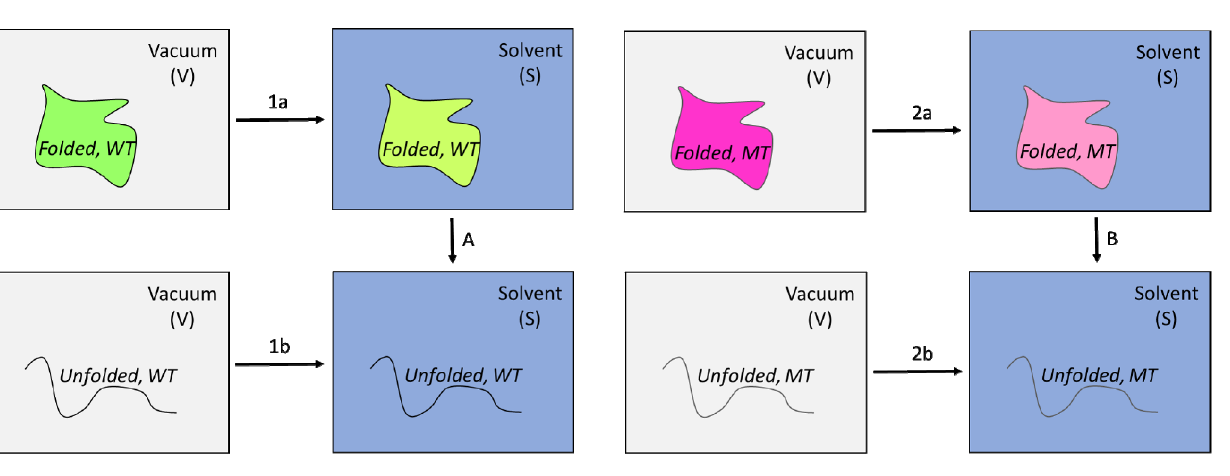
Figure 2. Schematic diagram of different states involved in the energy calculations and the corresponding equations used to predict the change of the folding free energy upon mutation. WT, Wild-type; MT, Mutant; Green: Folded WT protein in vacuum (V, gray); Light Green: Folded WT protein in solvent (S, blue); Violet: Folded MT protein in vacuum; Light Violet: Folded MT protein in solvent, Unfolded (U) states are represented by black curved